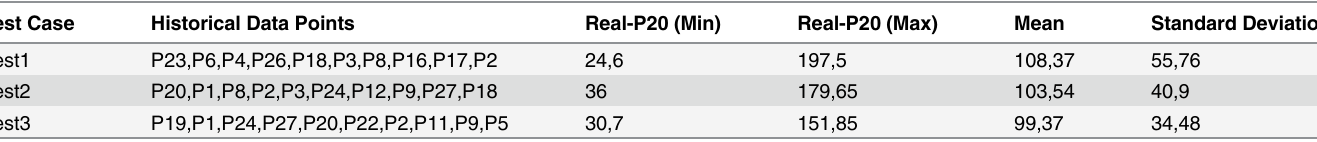
Table 6. Preparation Phase Datasets Characteristics.